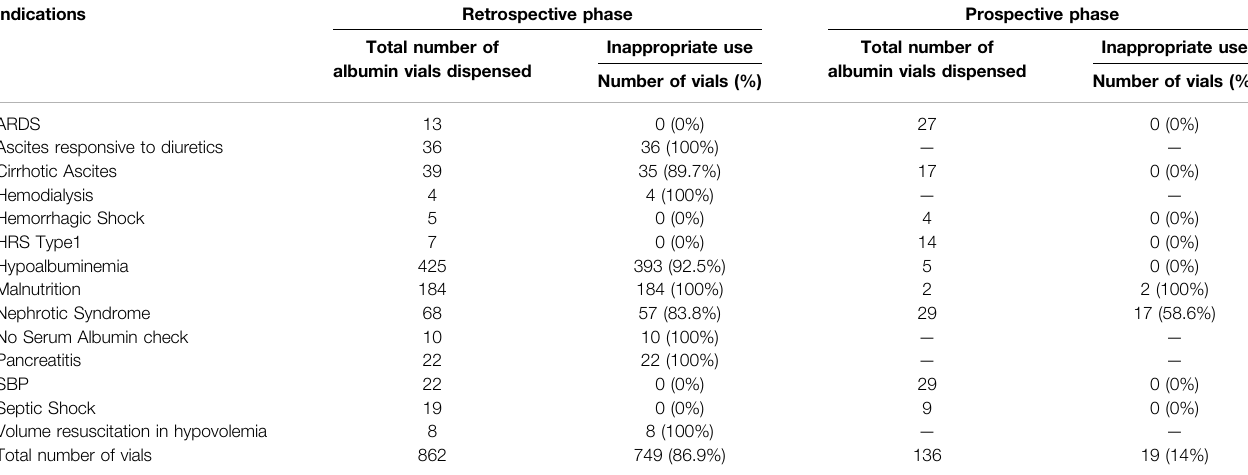
TABLE 3 | Total and inappropriate albumin vials dispensed in the retrospective and prospective phases. Indications Retrospective phase Prospective phase